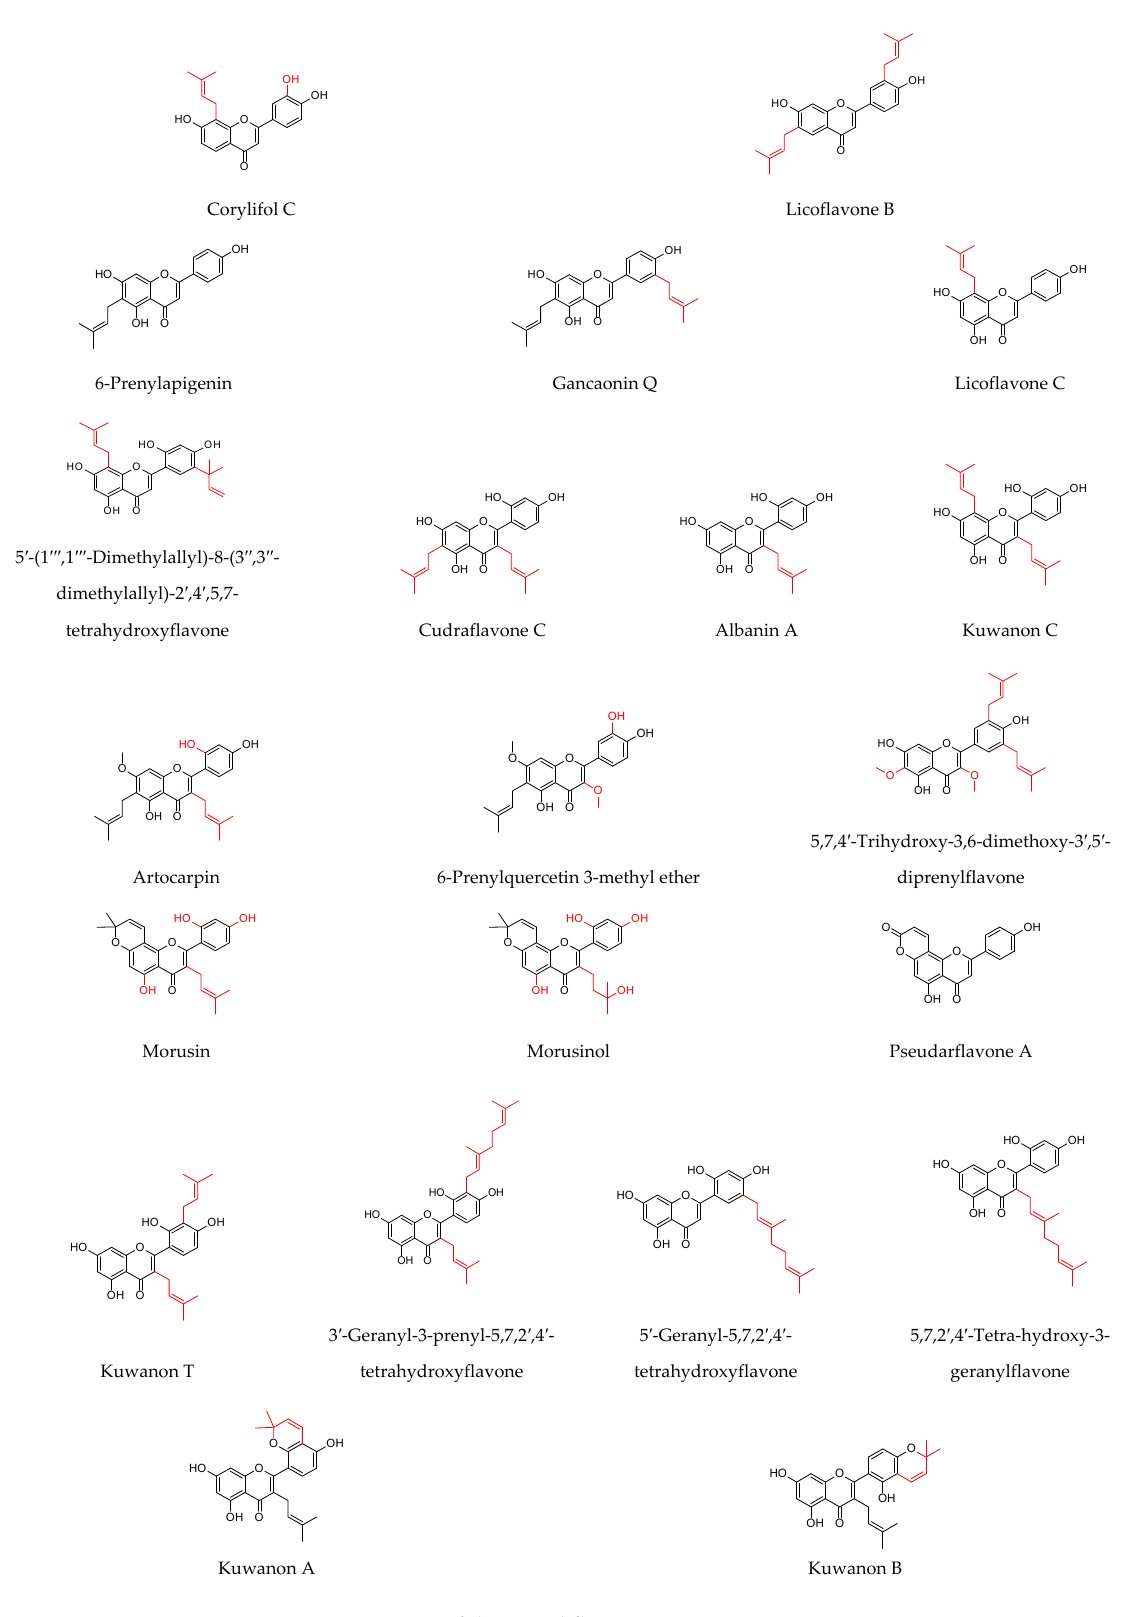
Figure 8. Structures of discussed